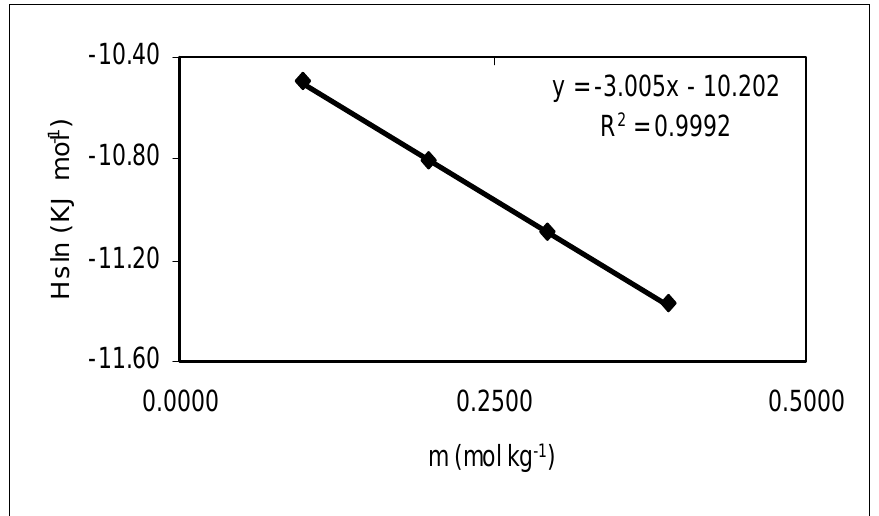
Figure 6. Enthalpy of Solution of Propanol in Water in Function to the Concentration of the Solution.